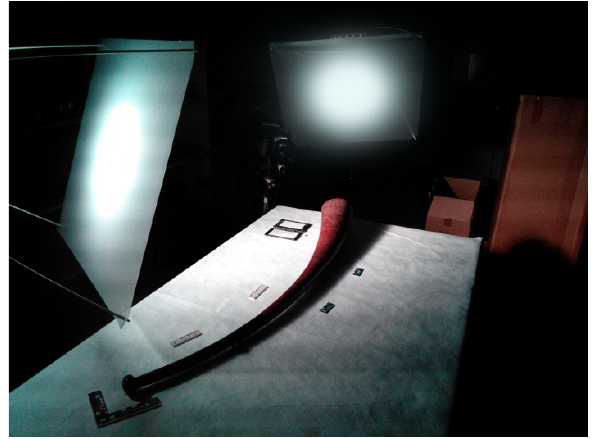
Figure 2: Multispectral photogrammetry setup used to digitize the horn.